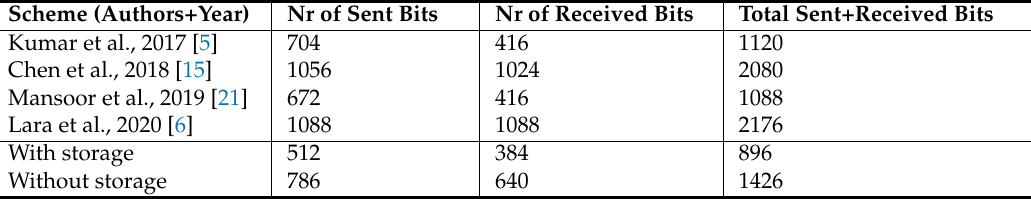
Table 4. Comparison of communication cost with related and recent